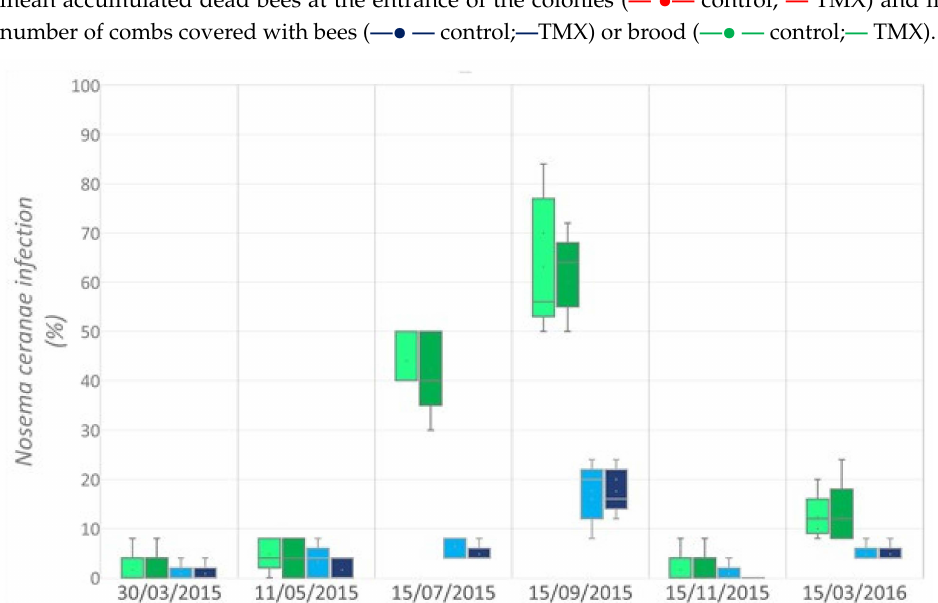
Figure 4. Box and Whisker plots of N. ceranae infection in non-forager honey bees (IB; control; TMX) and forager honey bees (FB; control;